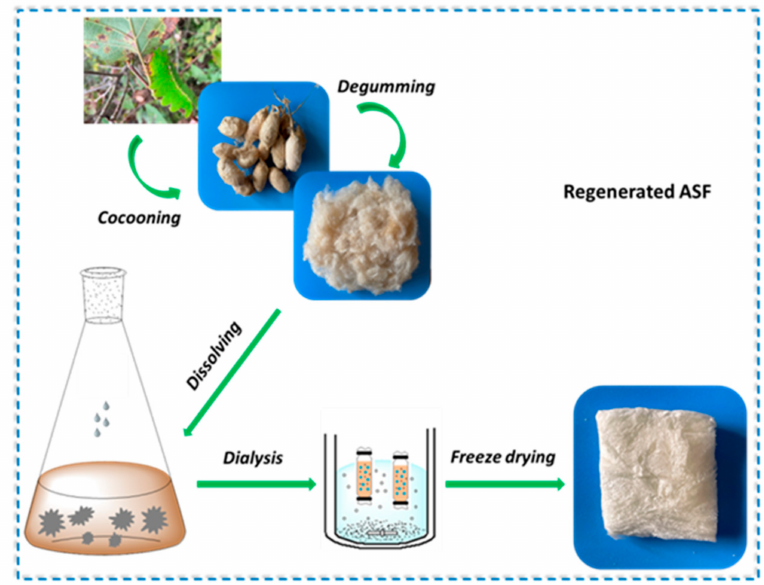
Figure 1. Preparation of regenerated A. pernyi silk